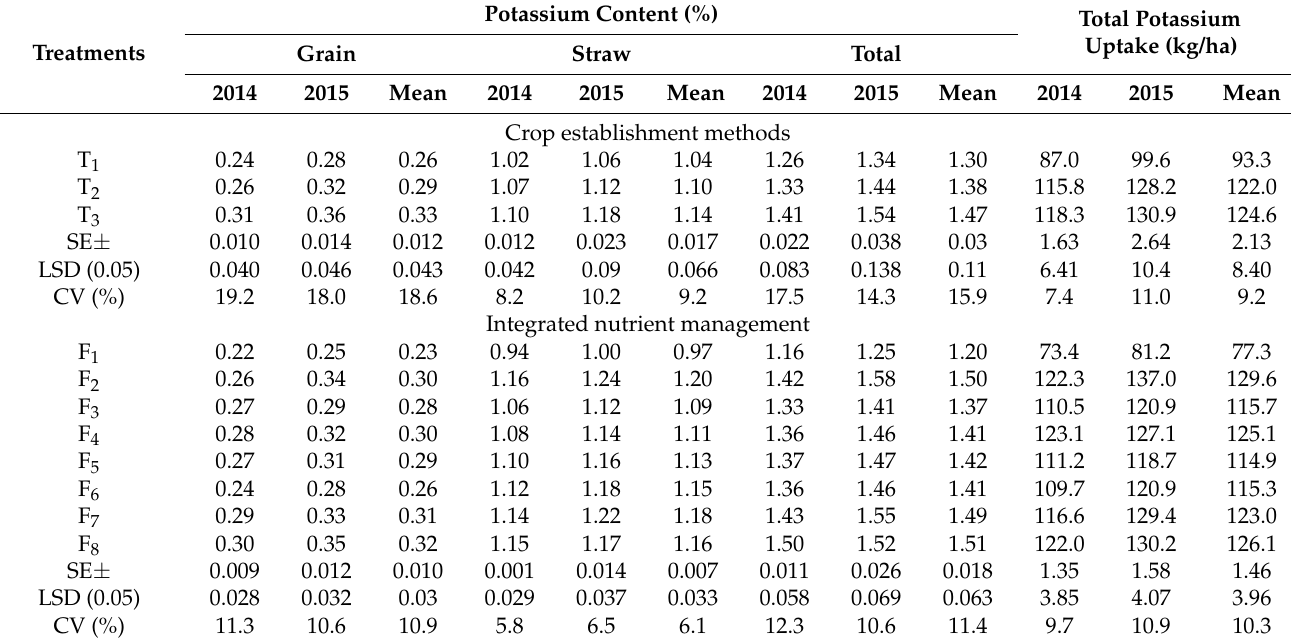
Table 3. Crop establishment methods and integrated nutrient management influence on potassium contents and potassium.